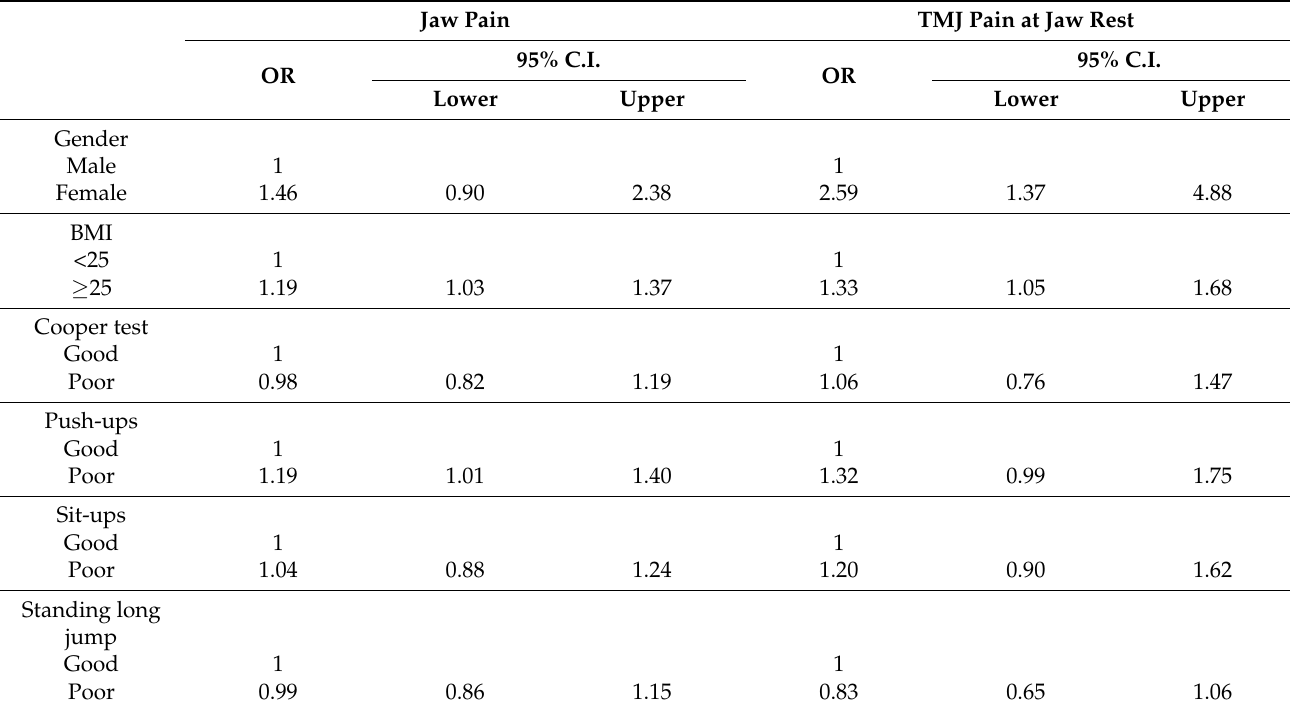
Table 3. OR and 95% confidence intervals (95% C.I.) from regression model on the association between jaw pain and TMJ pain at jaw rest and objectively measured physical performance